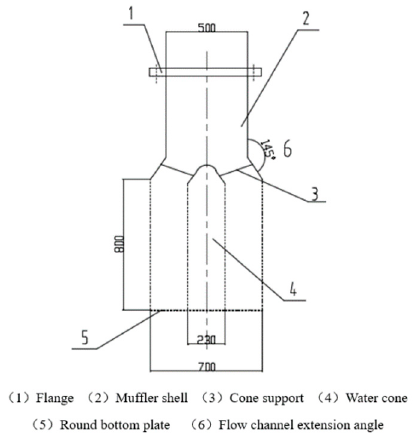
Figure 1. Structure diagram of the muffler.